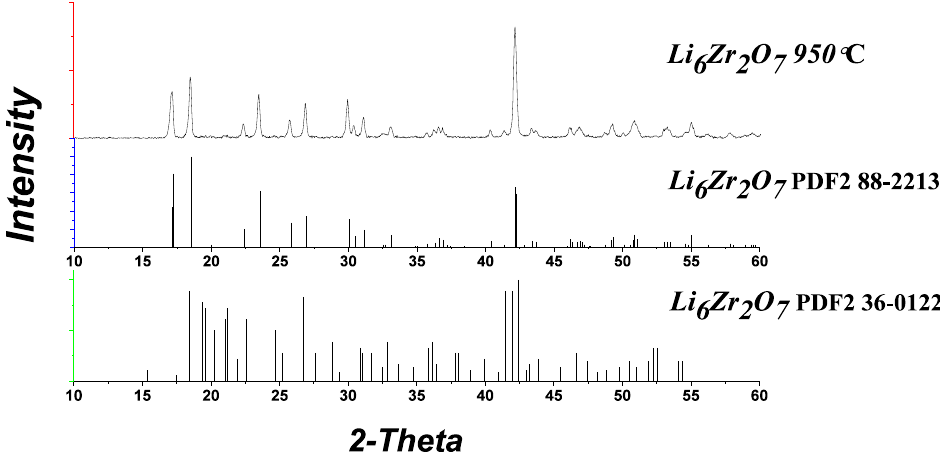
Figure 4. XRD patterns for Li 6 Zr 2 O 7 obtained by glycine-nitrate method from Li 2 CO 3 and Zr(OH) 2 CO 3 · 5.5H 2 Oat 950 ◦ C.